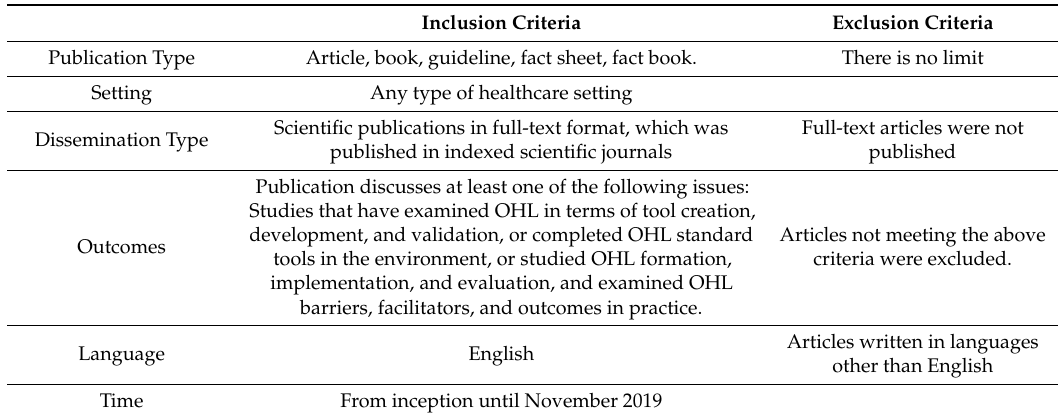
Table 1. Inclusion / Exclusion